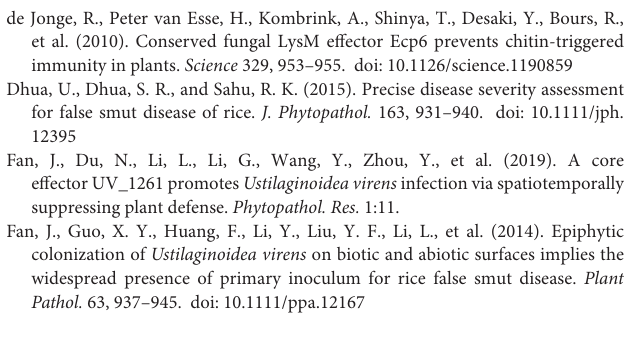
Supplementary Figure 1 | Multiple sequence alignment. Amino acid sequences of UvCBP1, together with MoChia1 (G4MXR2), MpChi (A0A385MIS5), and MrChi (A0A0W0FPC8) retrieved from UniProt database, were aligned by MEGA5.1 with default parameters. Red asterisks indicate chitin-binding residues as reported in MpChi (Fiorin et al., 2018). Red rectangle indicates the signal peptide of UvCBP1. The regions with homology over 50% were boxed, and identical residues were shaded in black. Supplementary Figure 2 | Western blot with anti-GFP antibody for confirmation of protein expression in N. benthamiana (A) and Arabidopsis (B) . Supplementary Figure 3 | In planta expression of UvCBP1 suppresses chitin-induced expression of defense-related genes in rice spikelets. Expression of UvCBP1 (A) and defense-related genes (B) were examined by RT-qPCR using OsUbi as the reference gene. Data are represented as means ± SD of three biological replicates. Asterisk indicates significant difference determined by Student’s t test ( ∗∗ P < 0.01). Supplementary Table 1 | Primers used in this